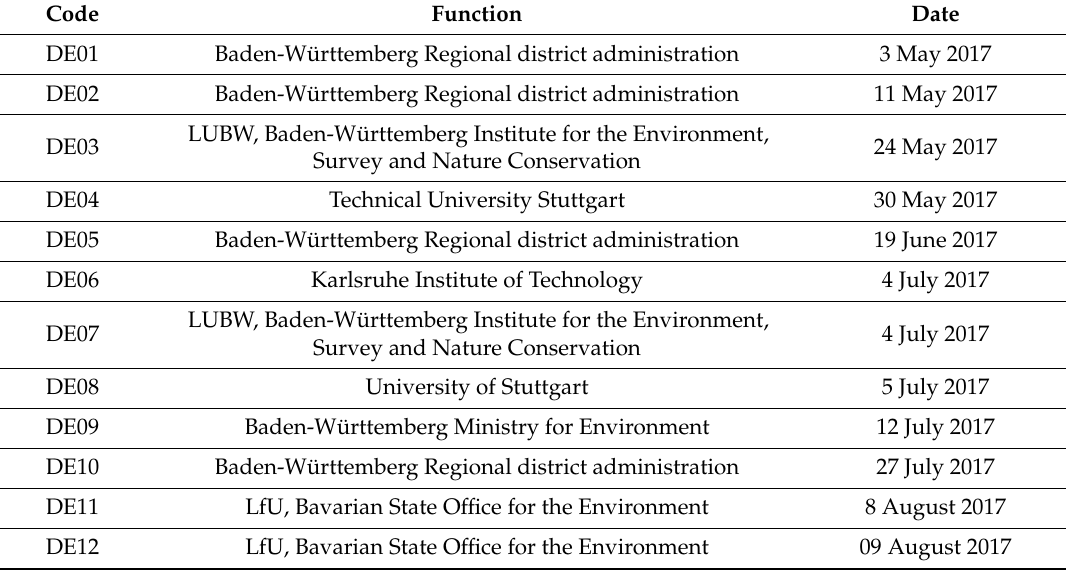
Table A1. List of expert interviews conducted in Baden-Württemberg and Bavaria.